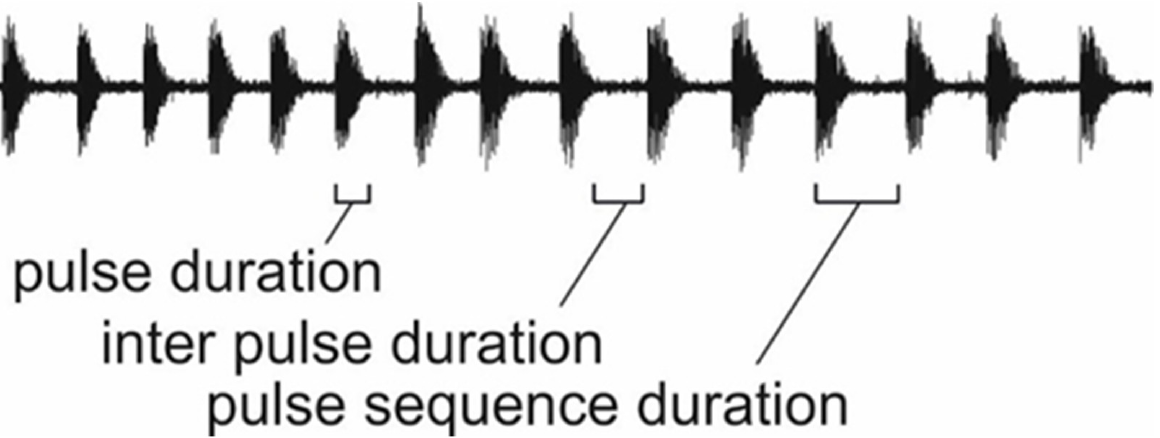
Figure 1. Temporal structure of vibrational pulse trains produced by A. ferruginea .